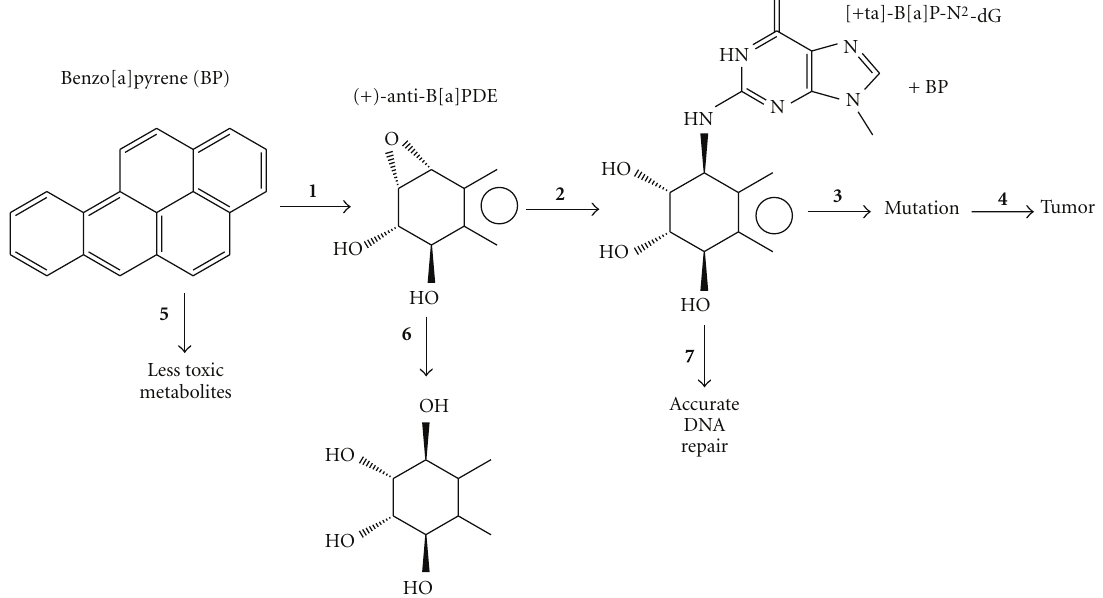
Figure 1: Mutagenesis/carcinogenesis paradigm with benzo[a]pyrene. Steps in the horizontal direction lead toward carcinogenicity, and include metabolic activation (step 1), reaction with DNA (step 2), adduct mutagenesis (step 3), and tumorigenesis (step 4). Steps in the vertical direction lead to diminished carcinogenicity, and include metabolic detoxification (step 5), carcinogen deactivation (step 6), and DNA repair (step 7). Diminished carcinogenicity is also associated with other cellular processes, such as delaying the cell cycle and apoptosis